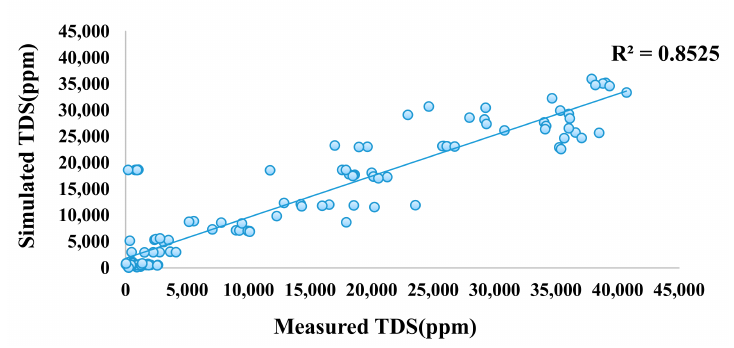
Figure 7. The calibrated results of Pingtung Plain SWI